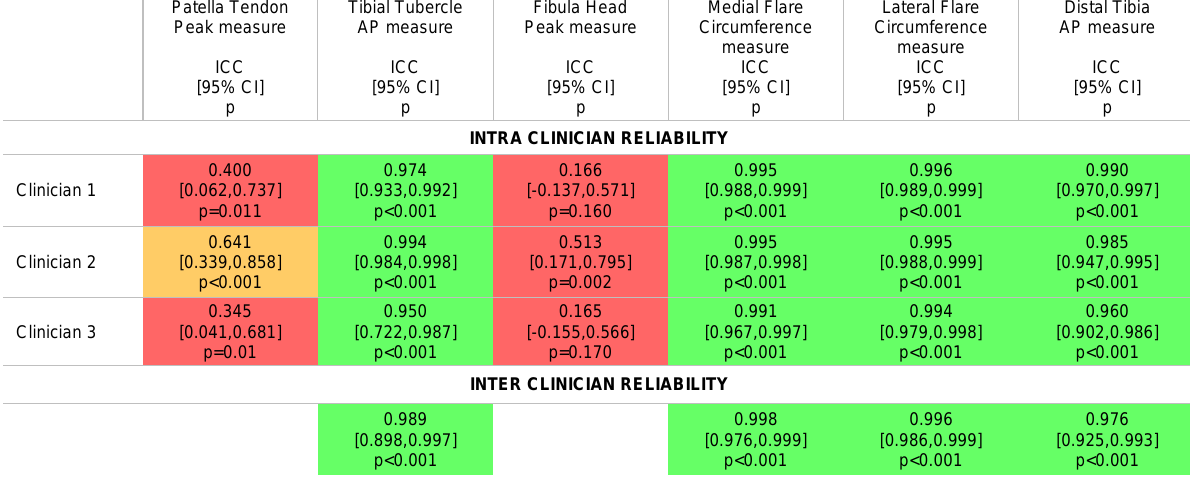
Table 3: Standard deviation (SD) for each